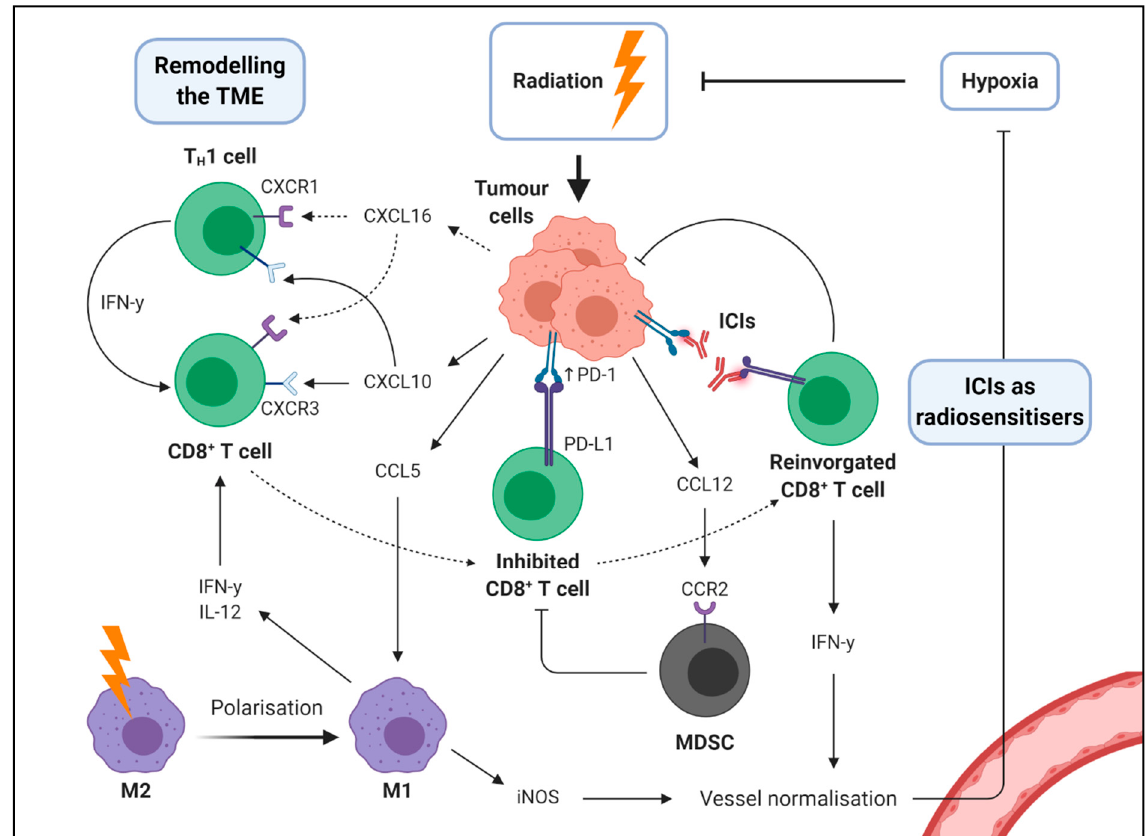
Figure 3 . Radiation therapy can shape the immune response just as immunotherapy can shape the response to radiation therapy. Radiation induces production of a variety of chemokines that can facilitate and antagonise the anti-tumour response: T cells and M1 macrophages contribute to tumour elimination and can be recruited by CXCL16 or CXL10, and CCL5, respectively; myeloid-derived suppressor cells (MDSCs) are immunosuppressive and can be recruited by radiation-induced expression of CCL12. Immune checkpoint inhibitors (ICIs) boost anti-tumour immunity by disrupting suppressive signalling molecules such as PD-1, PD-L1 and CTLA-4 (latter not shown). By recruiting T cells (via aforementioned mechanisms) radiation therapy can augment this phenomenon. Furthermore, cytokines released by immune cells including IFN- γ from CD8 + T cells can promote tumour vessel normalisation counteracting hypoxia which promotes radioresistance: thus, by enhancing T cell responses ICIs can act as radiosensitisers.